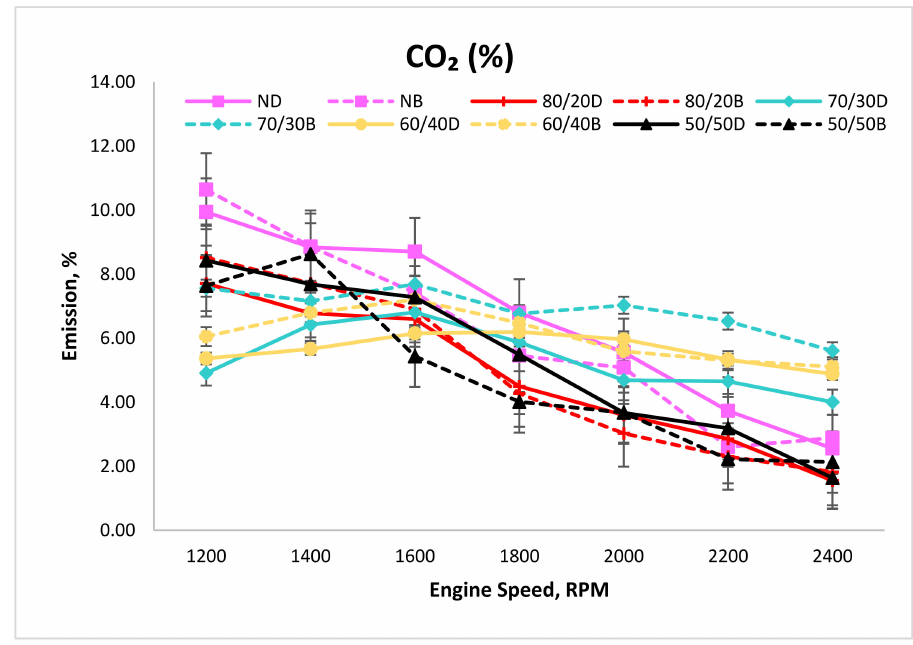
Figure 8. CO 2 emission at variable